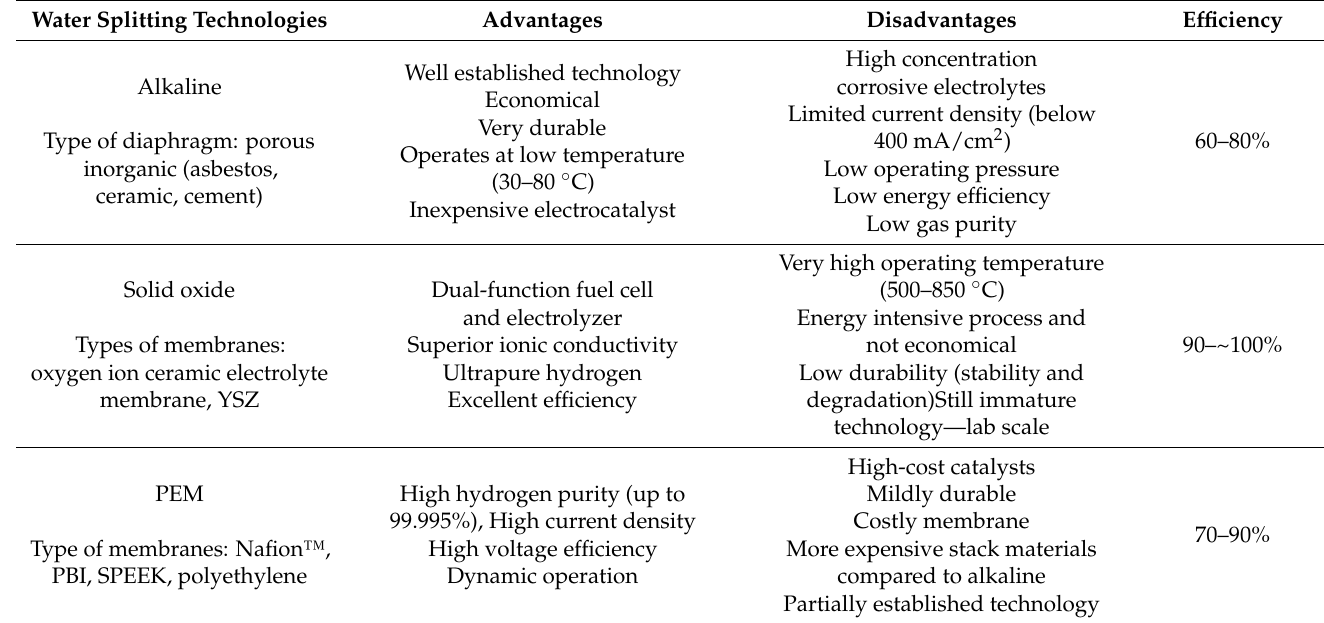
Table 7. Summary of hydrogen production by water splitting technologies along with the types of diaphragm/membrane used, advantages, disadvantages, and efficiencies [19,21,27,34,81,83,114,128,142]. Water Splitting